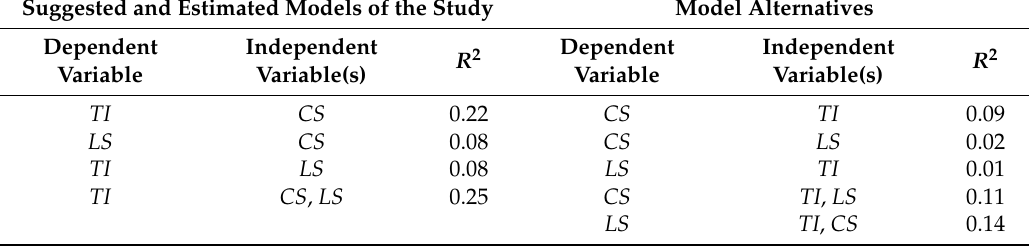
Table 13. Control for model specification error: comparisons of model alternatives. (CS: Commuting stress, LS: Life satisfaction, TI: Turnover